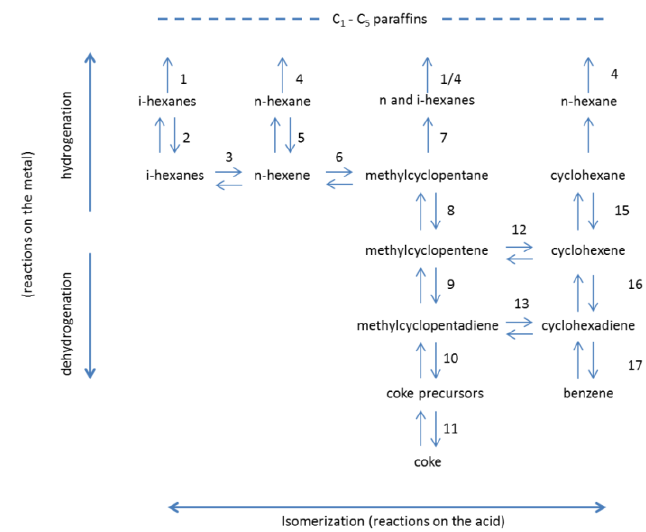
Figure 2. Reaction mechanisms using a bifunctional catalyst (metal-acid/sites) [12].